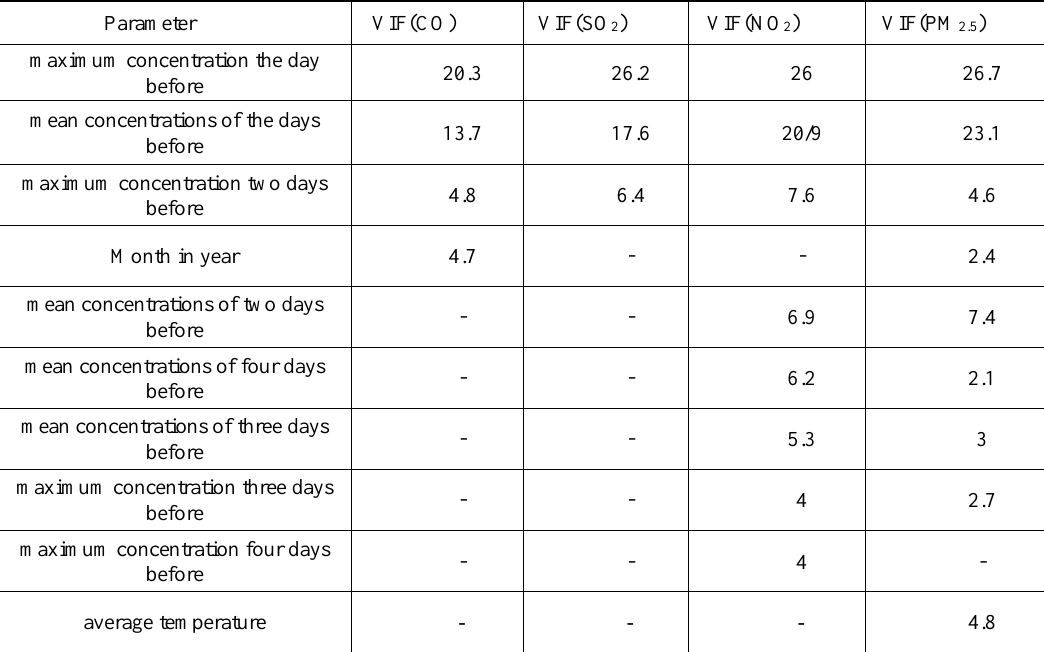
Table 2. Results of the RFFS method to estimate the importance of each attribute represented in percent